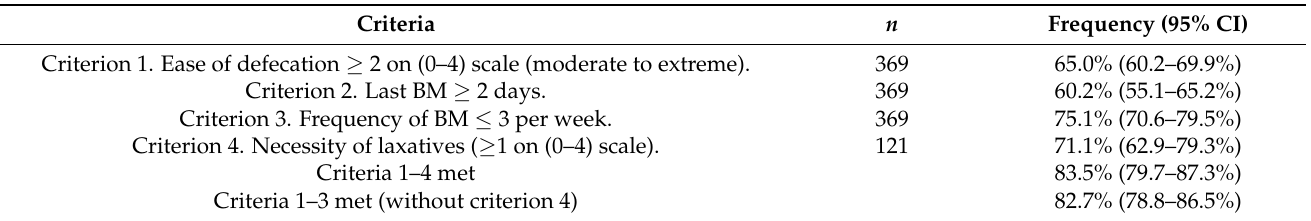
Table 4. The proportion of patients meeting the criteria for